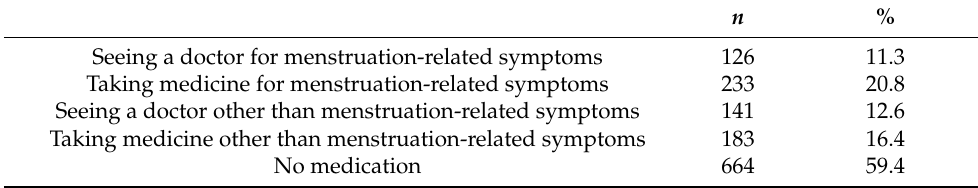
Table 5. Statement of medication for menstruation-related symptoms among estrogen-like supple- ment users.